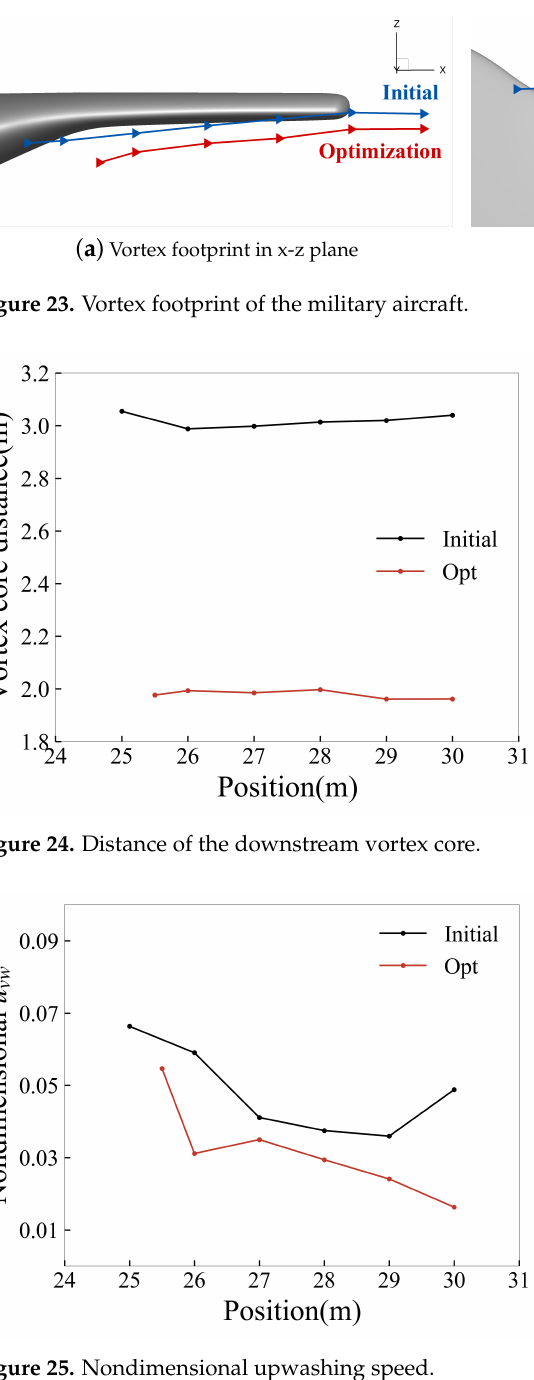
Figure 25. Nondimensional upwashing